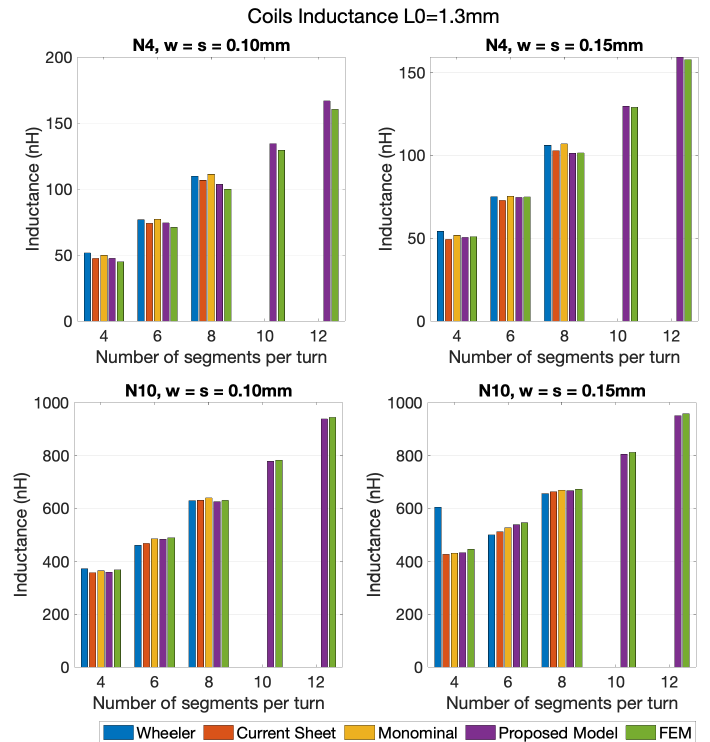
Figure 11. Comparison between several methods of inductance calculation of coils with 8 and 10 turns, for L 0 = 1.3 mm, w = s = 0.10 mm and w = s = 0.15 mm, and for 4, 6, 8, 10, and 12 segments per